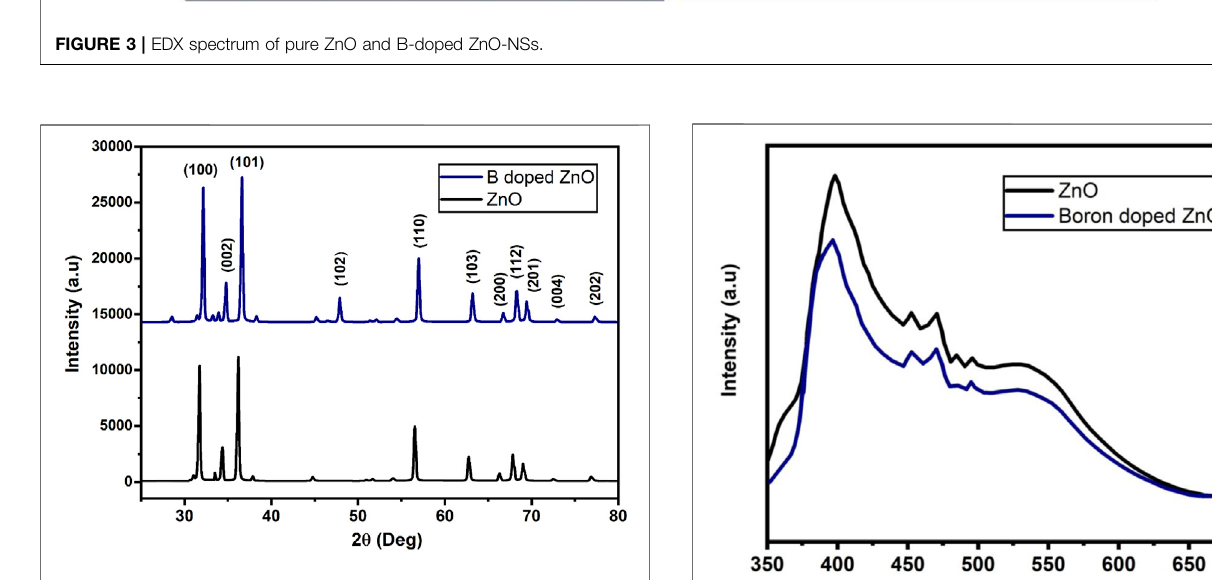
FIGURE 4 | The X-ray diffraction pattern for pure (black) and B doped ZnO-NSs (blue).